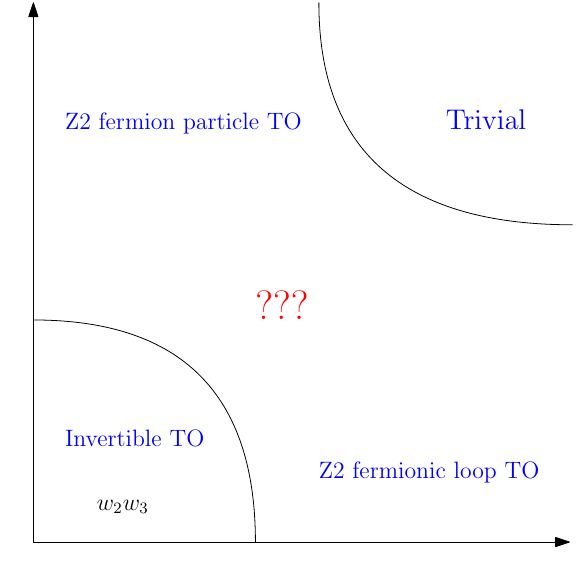
Figure 9: Sketch of the phase diagram of the Hamiltonian model (70) in (4 + 1)D. The phase transition(s) along the 45 degree line κ trivial invertible topological order on the lower left corner. The (cid:90) topological order in (4 + 1)D has three non-trivial basic excitations: electric loop, magnetic loop, and dyonic loop, where the magnetic and dyonic loop excitations are fermionic while the electric loop excitation is bosonic (similar theory with only bosonic loop excitations is discussed in Ref. [ 53 ]